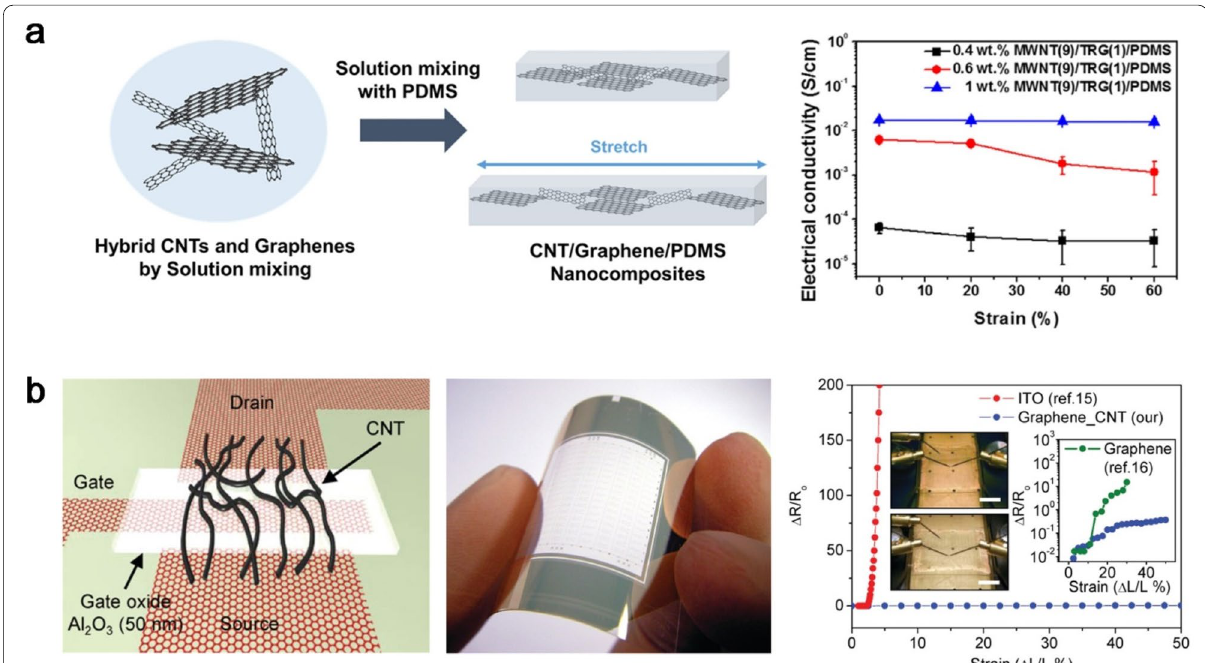
Fig. 2 Electronics based on CNT graphene hybrid. a Stretchable electrode based on CNT − nanocomposite. Reproduced with permission [45]. Copyright 2016, American Chemical Society. b Flexible transistor utilizing CNT channel, graphene electrodes, and Al 2 O 3 dielectric. Reproduced with permission [21]. Copyright 2011, American Chemical